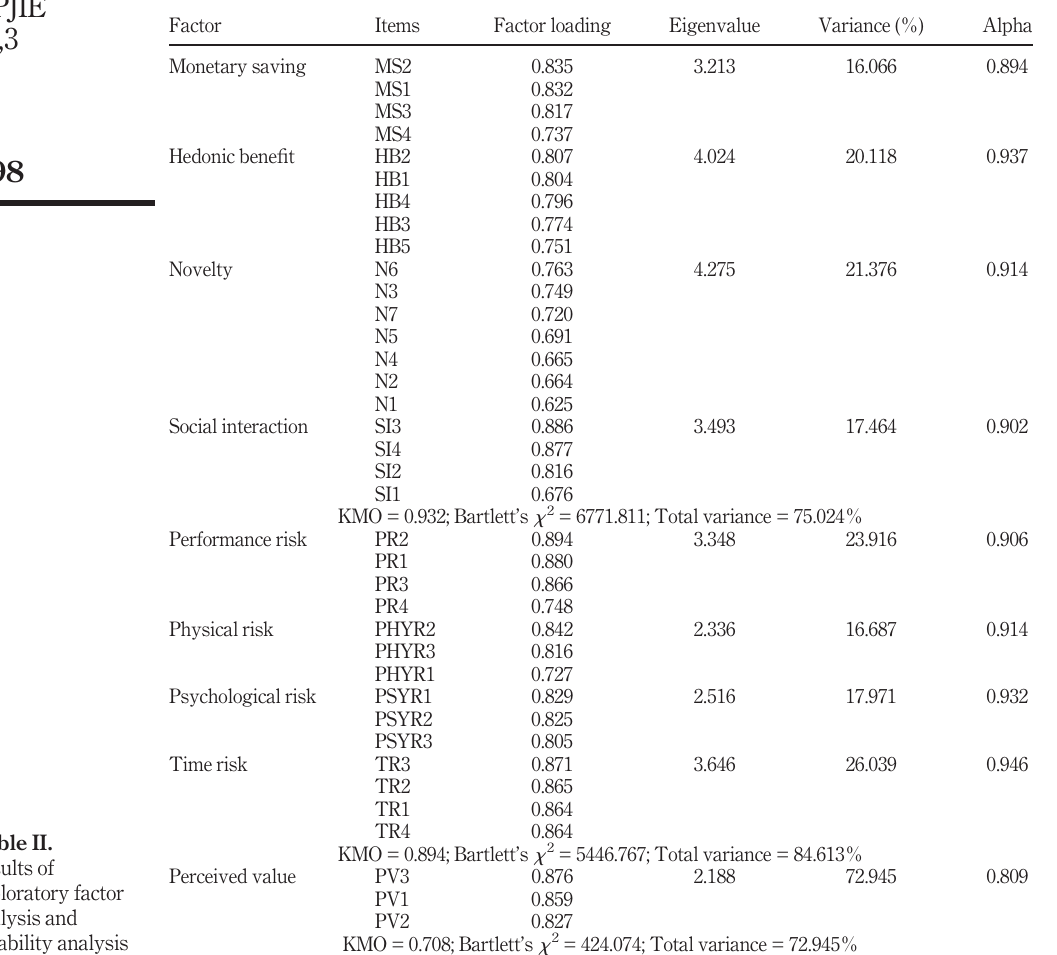
Table II. Results of exploratory factor analysis and reliability